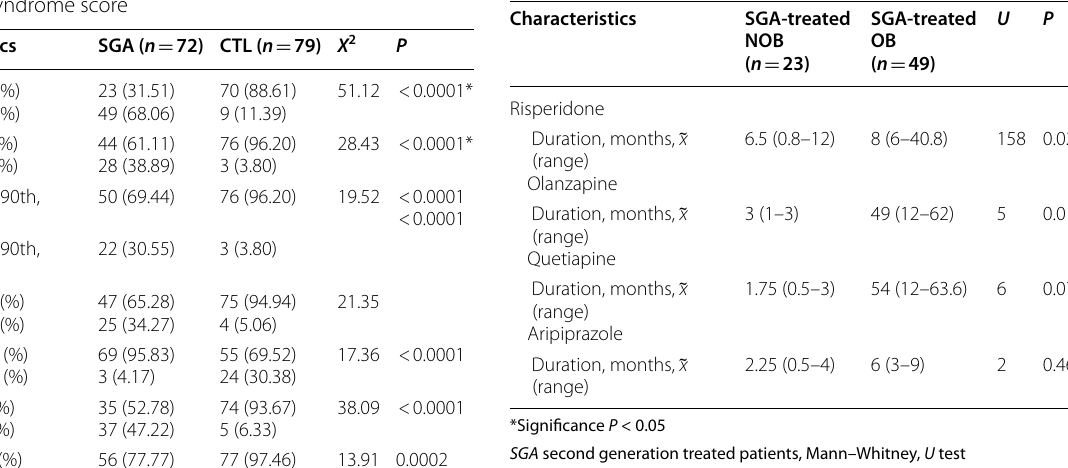
Table 3 Difference of SGA treatment type duration between non-obese and obese patients